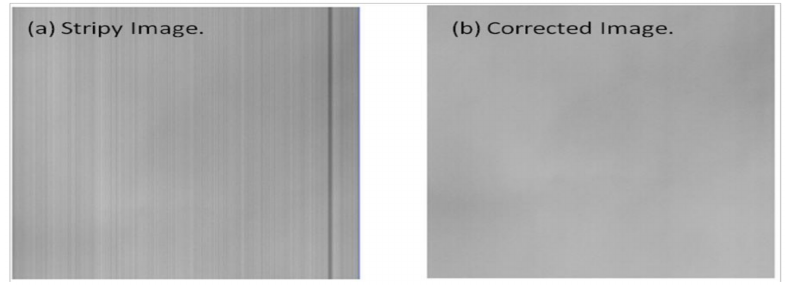
Figure 3. ( a ) Characteristic striping in the original satellite imagery; ( b ) the same image after applying relative radiometric calibration